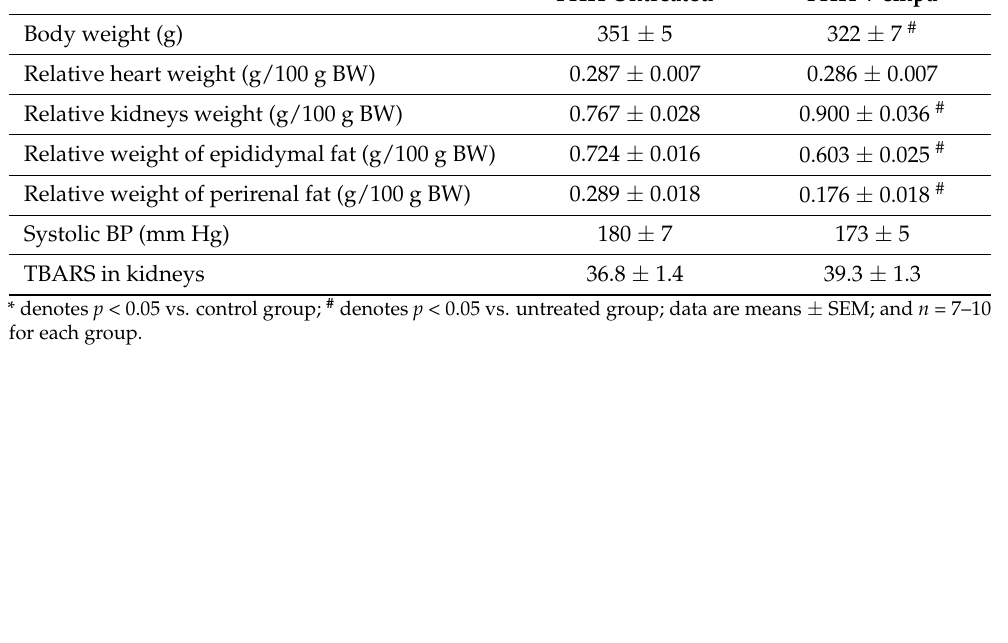
Table 1. Body and organ weights, as well as blood pressure and TBARS levels, in fawn-hooded hypertensive (FHH) rats treated with empagliflozin (empa). FHH Untreated FHH + empa Body weight (g) 351 ± 5 322 ± 7 # Relative heart weight (g/100 g BW) 0.287 ± 0.007 0.286 ± 0.007 Relative kidneys weight (g/100 g BW) 0.767 ± 0.028 0.900 ± 0.036 # Relative weight of epididymal fat (g/100 g BW) 0.724 ± 0.016 0.603 ± 0.025 # Relative weight of perirenal fat (g/100 g BW) 0.289 ± 0.018 Systolic BP (mm Hg) TBARS in